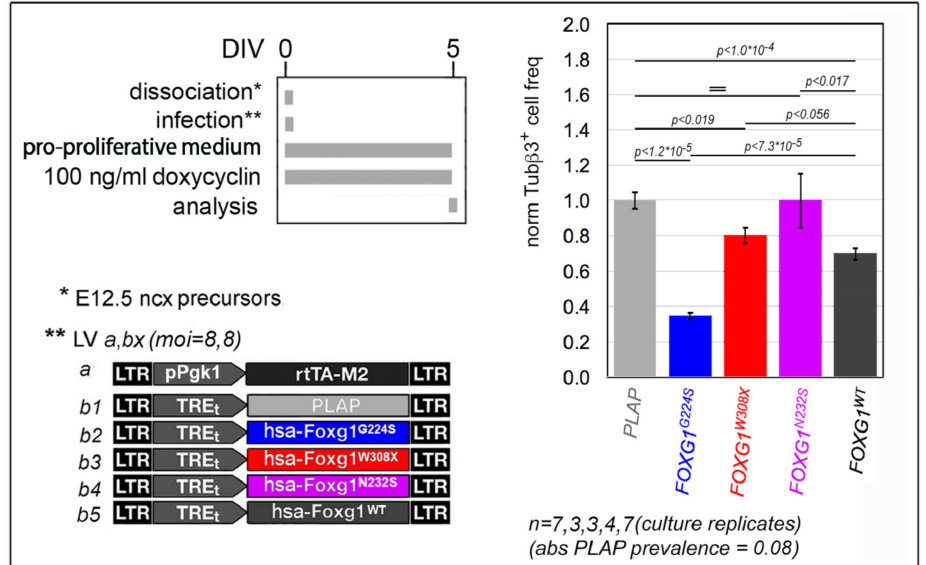
Figure 2. Impact of mutant FOXG1 alleles on neuronogenic rates. To left, protocols and lentiviral vectors employed, to right, results. Shown are frequencies of Tubb3 + newborn neurons originating from neural precursors expressing FOXG1 G224S , FOXG1 N232S , FOXG1 W308X and FOXG1 WT alleles, in the presence of growth factors (GFs). Data normalized against Plap -expressing controls (control, absolute Tubb3 + cell frequency = 0.08). Statistical evaluation of results by t -test (one-tailed, unpaired). =, not significant. n is the number of biological replicates, i.e., independently cultured and engineered aliquots originating from a common neural